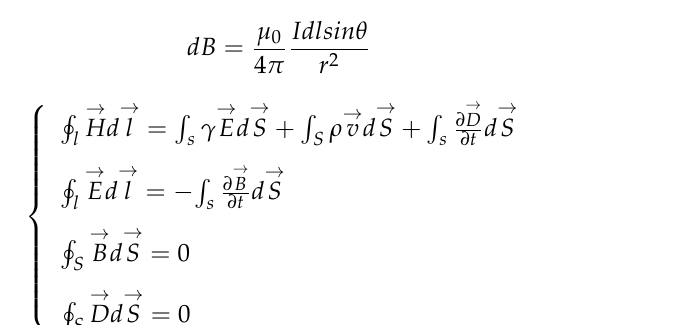
Figure 7. Schematic diagram of the new coil structure.